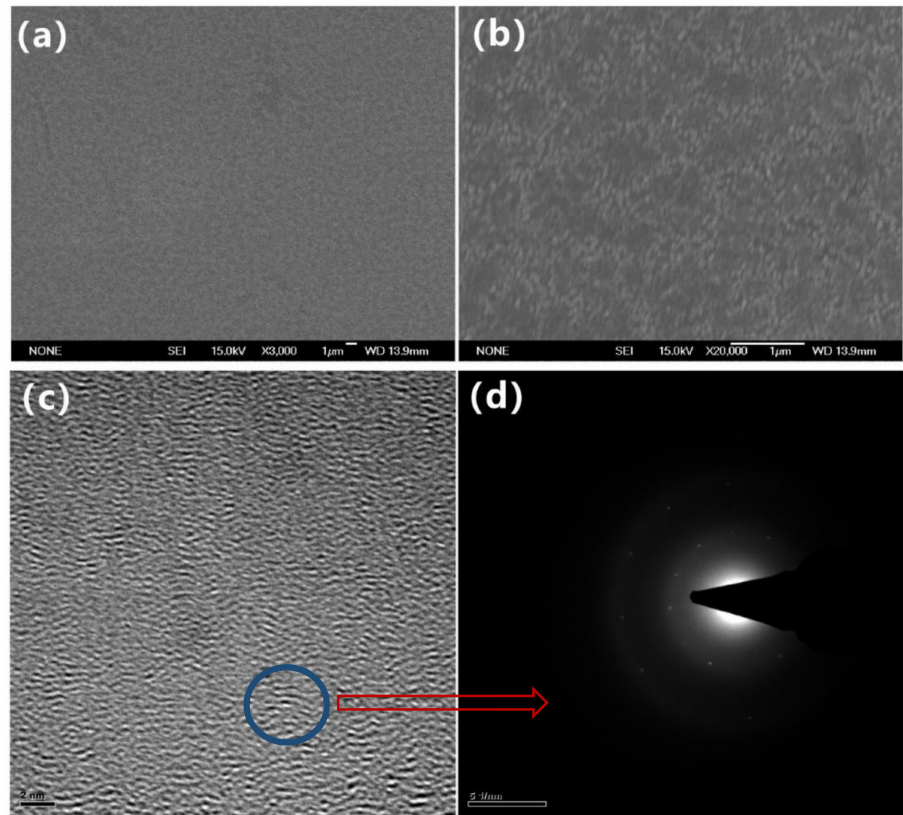
Figure 1. ( a ) Surface topography of NGFs by SEM with magnification of 3000x; ( b ) surface topography of NGFs by SEM with magnification of 20,000x; ( c ) morphologies of NGFs by TEM; ( d ) transmission electronic di ff raction pattern of the area indicated in ( c